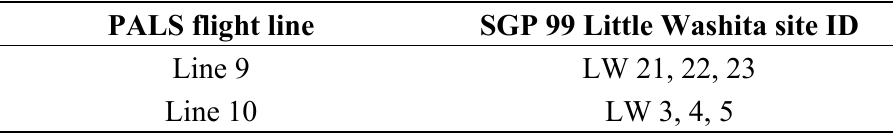
Table 1. Study area of PALS flight line and Little Washita site